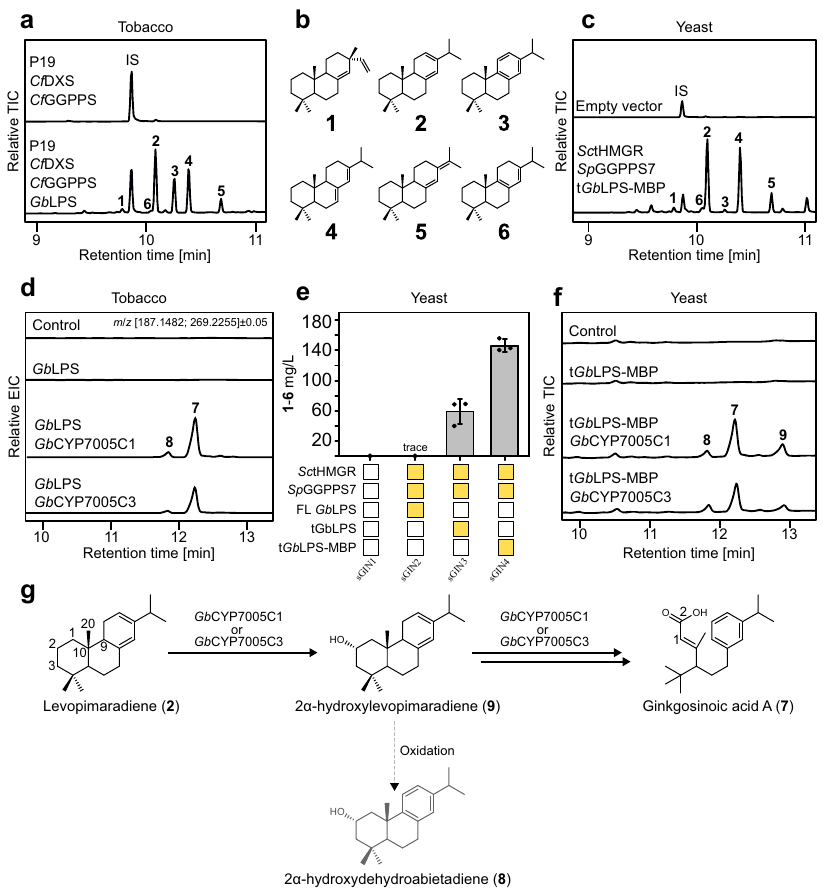
Fig.2|GinkgosinoicacidA(7)isanintermediatefromlevopimaradienetoward ginkgolides. a GC – MS chromatograms of hexane extracts of N. benthamiana (tobacco) leaves transiently expressing Cf DXS ( C. forskohlii 1-deoxy- D -xylulose 5-phosphate synthase) and Cf GGPPS ( C. forskohlii geranylgeranyl pyrophosphate synthase) with or without Gb LPS ( G. biloba levopimaradiene synthase). In all sam- ples,the P19 silencing suppressorisco-expressed.ISinternal standard. b Chemical structure of compounds 1 – 6 identi fi ed as Gb LPS products (Supplementary Fig. 1). c GC – MSchromatogramsofhexaneextractsof S.cerevisiae cellscarryinganempty vector or expressing Sc tHMGR (a truncated version of yeast 3-hydroxy-3-methyl- glutaryl-coenzyme A reductase), Sp GGPPS7 ( Synechococcus sp. geranylgeranyl pyrophosphate synthase) with a truncated version of codon-optimized Gb LPS fused with maltose-binding protein (MBP) for optimal expression. IS internal standard. d Transient co-expression of Gb LPS together with either Gb CYP7005C1 or Gb CYP7005C3 in tobacco leaves. The co-expression led to the accumulation of